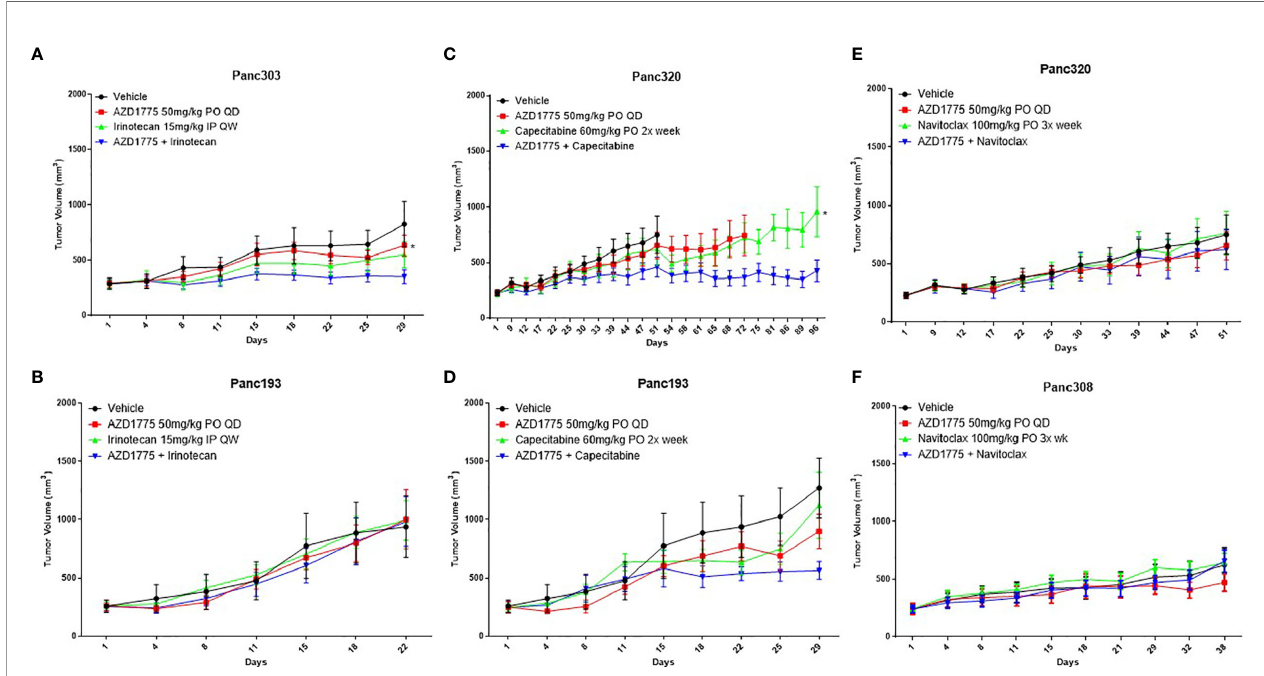
FIGURE 2 | Effect of AZD1775 alone or in combination with irinotecan, capecitabine, or navitoclax in PDAC PDX models of varying p53 status ( n = 10 mice/group). (A) Panc303 (p53 MT , KRAS MT ), (B, D) Panc193, (C, E) Panc320 (p53 MT , KRAS MT , SMAD4 MT , CDKN2A MT ), (F) Panc308 (p53 MT , KRAS MT , SMAD4 MT ). Statistical signi fi cance between the single agent and combination is indicated next to the single agent (* = p <